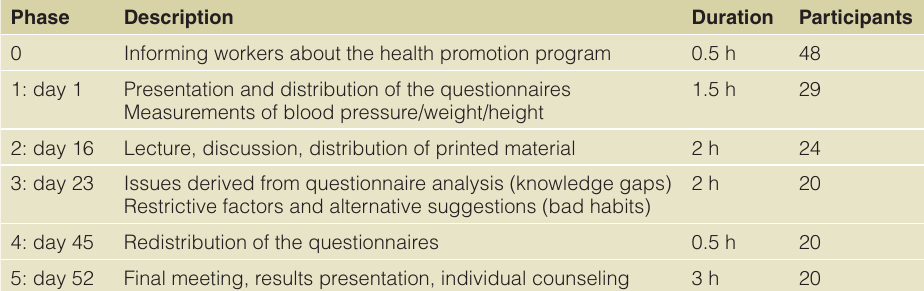
Table 1. Description of the health promotion